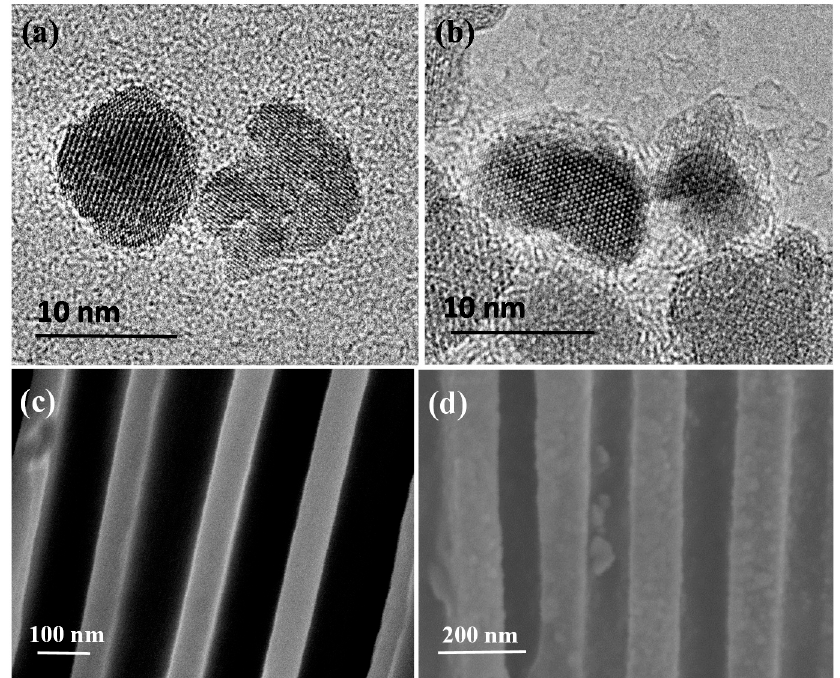
Figure 3. Transmission electron microscopy (TEM) images of magnetic nanoparticles (MNPs) ( a ) and antibody conjugated MNPs ( b ); scanning electron microscopy (SEM) images of cross-sectional view of bare nanoporous alumina membranes ( c ) and antibody functionalized nanoporous alumina membranes after histamine-MNPs conjugation capture ( d ).